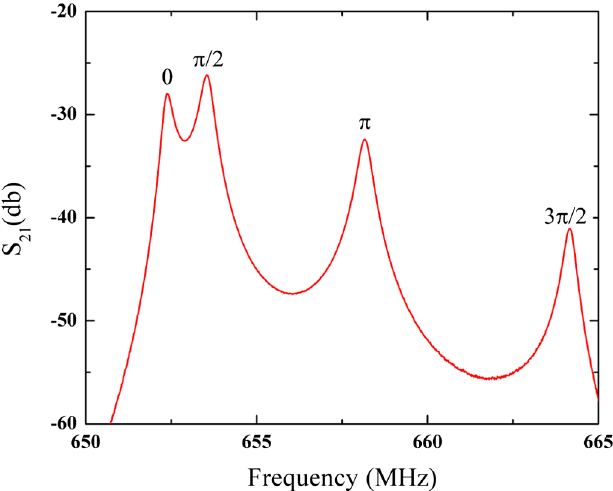
FIG. 41. The measured frequency spectrum of the 1:2 scaled model for the second resonator of the FAIR proton injector.